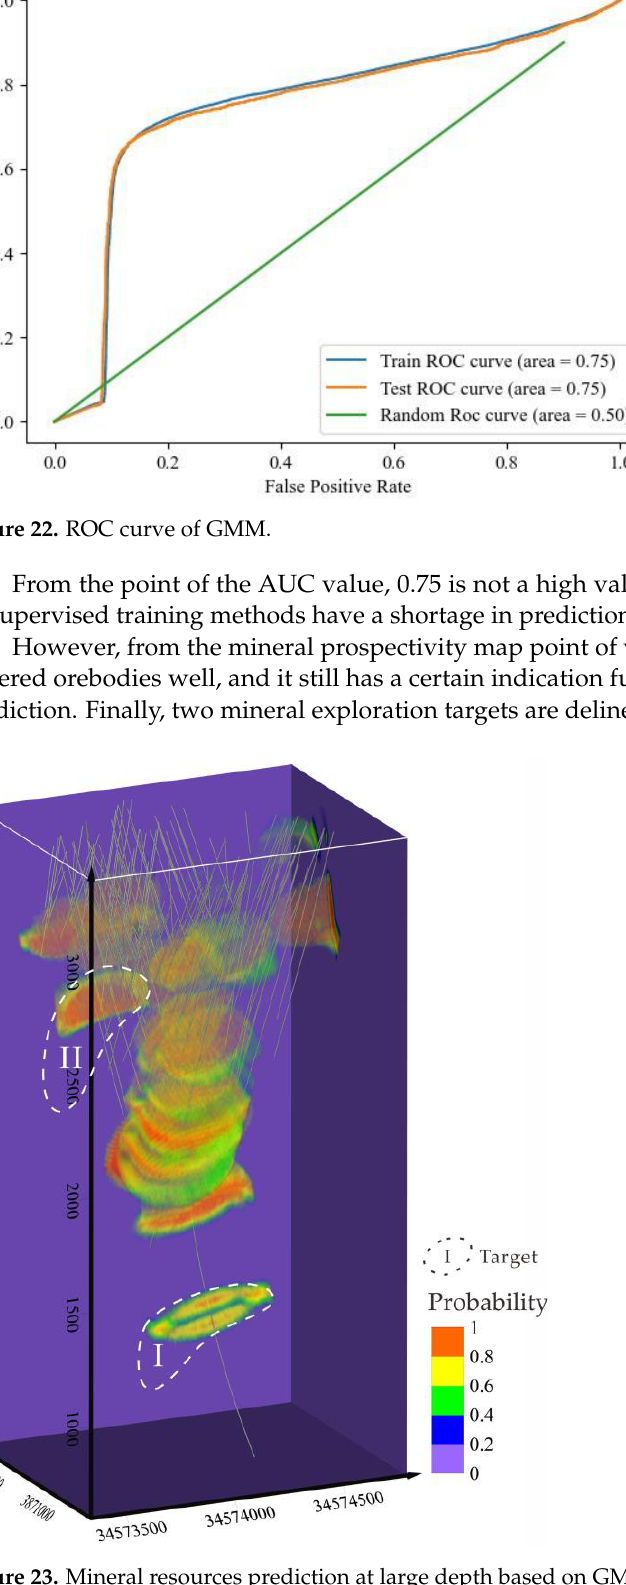
Figure 23. Mineral resources prediction at large depth based on GMM.